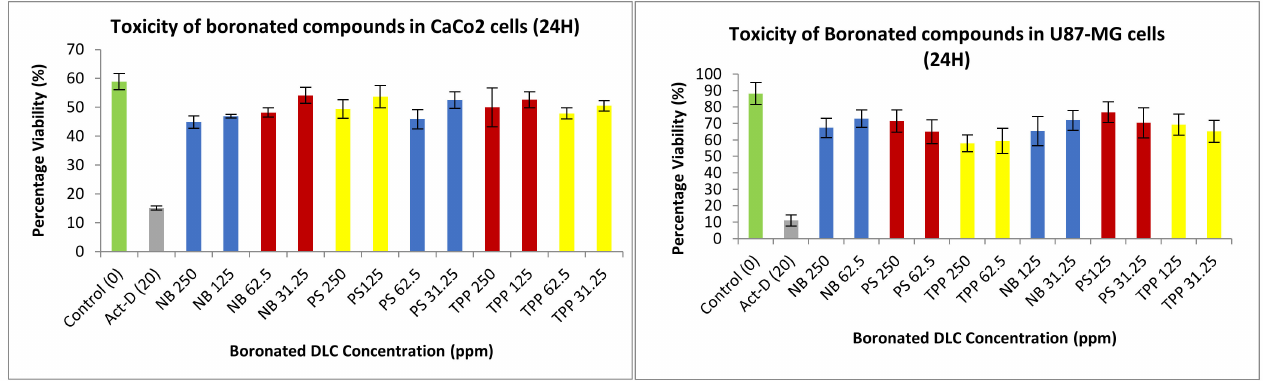
Figure 19. Toxicity of different concentrations of DLC functionalised carboranes on CaCo2 and U-87 MG cells after 24 h. Assays were repeated five times, with each assay containing triplicate readings for the same concentrations. Toxicity studies were performed at different concentrations for compound 2 (TPP), compound 4 (NB), and compound 6